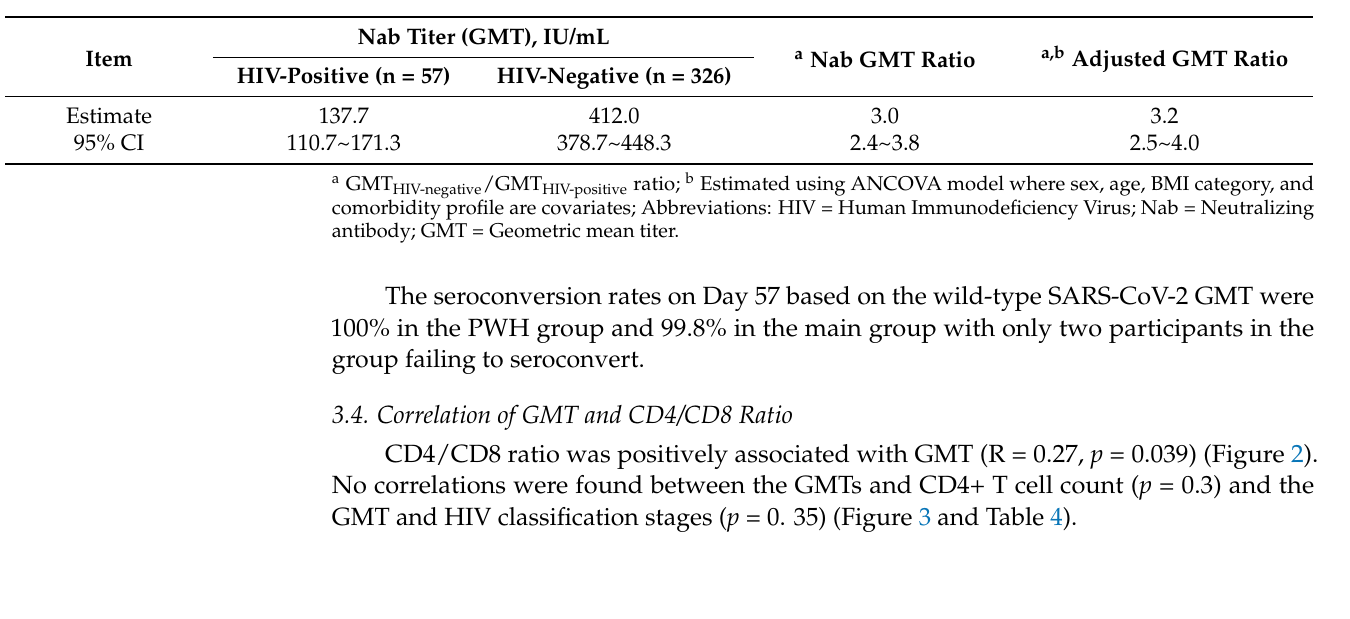
Table 3. Comparison of wild-type SARS-CoV-2 neutralizing antibody (Nab) in IU/mL among matched